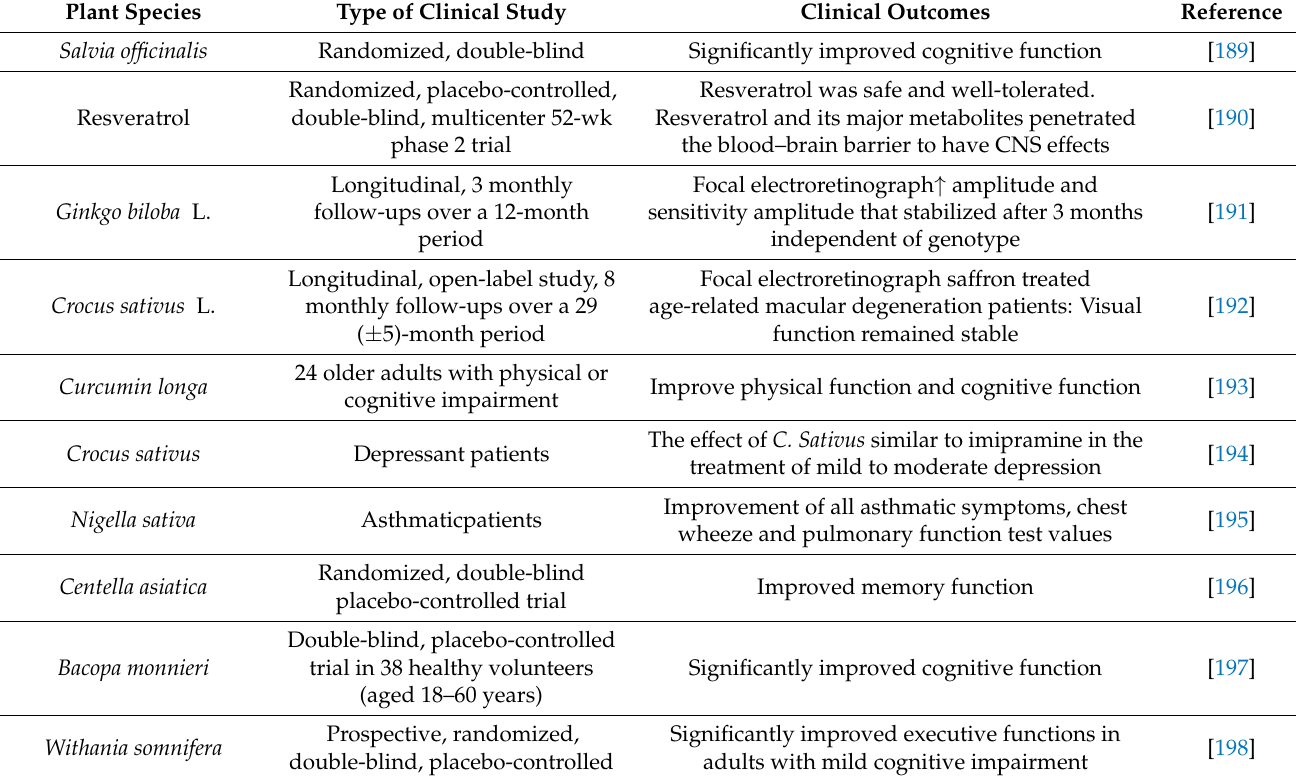
Table 3. Numerous medicinal plant extracts used in clinical trials and their